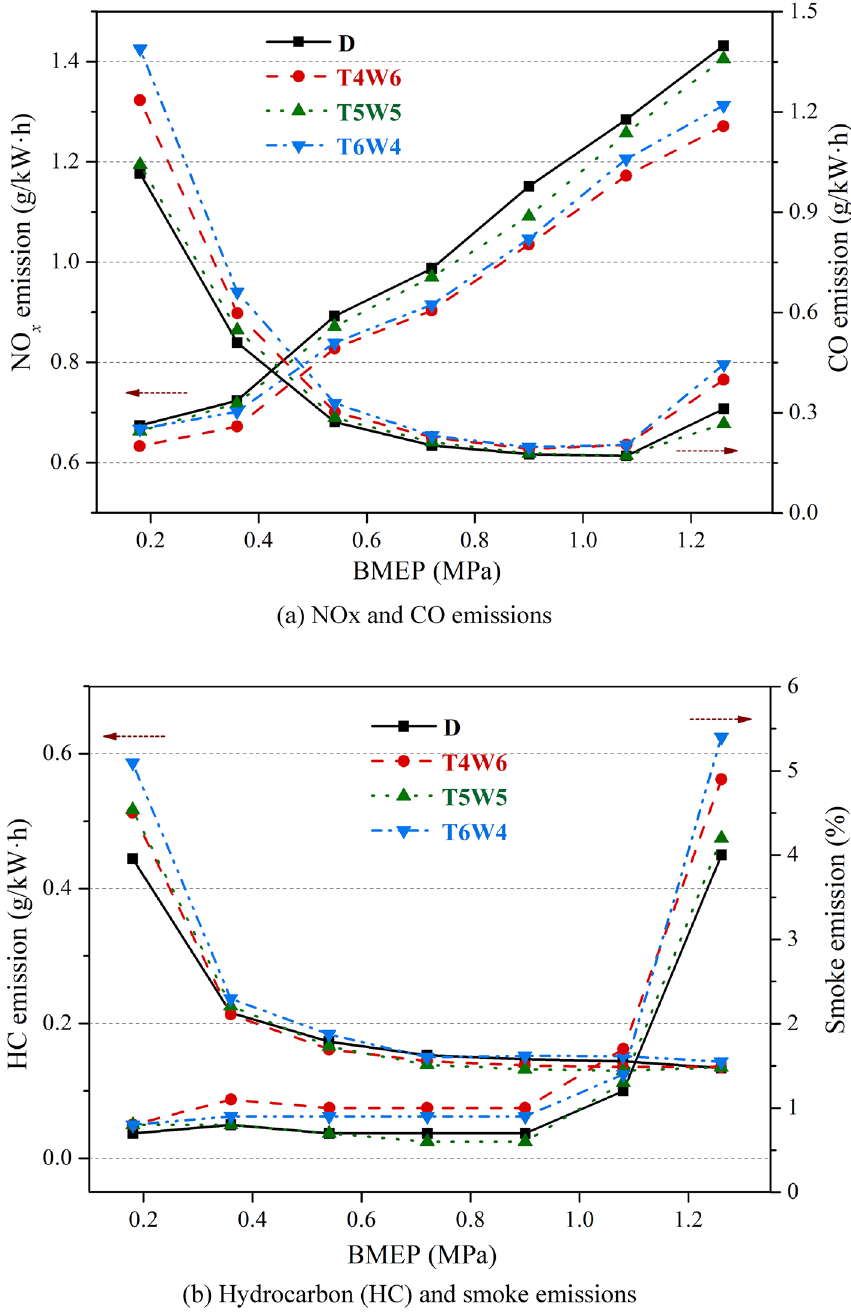
Figure 4. Emission characteristics of three kinds of coal-based diesel blends and petroleum